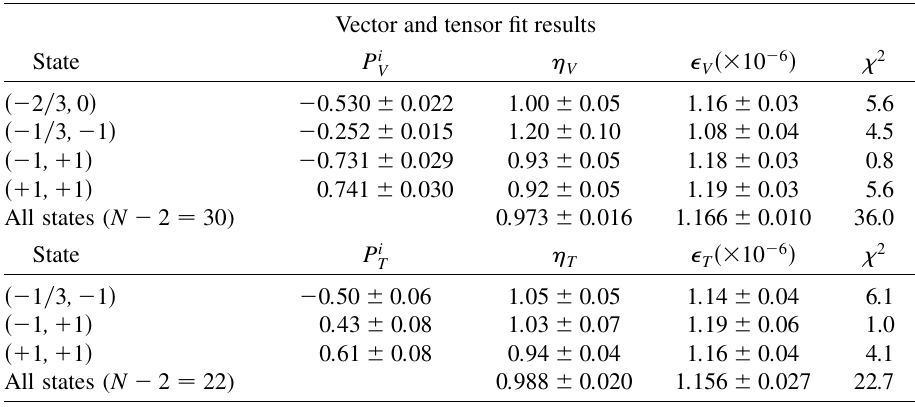
TABLE III. Fit results for Figs. 6 and 7 for (cid:18) f= 2 (cid:12) 75 Hz . Vector and tensor fit